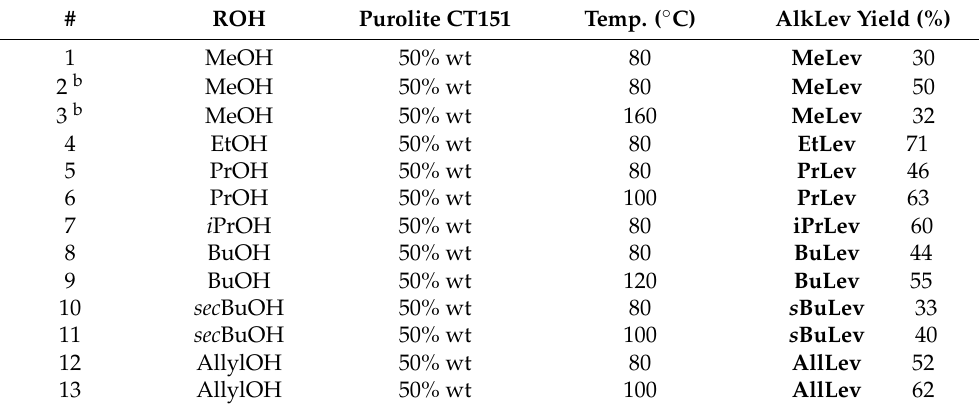
Table 3. Synthesis of alkyl levulinates a .